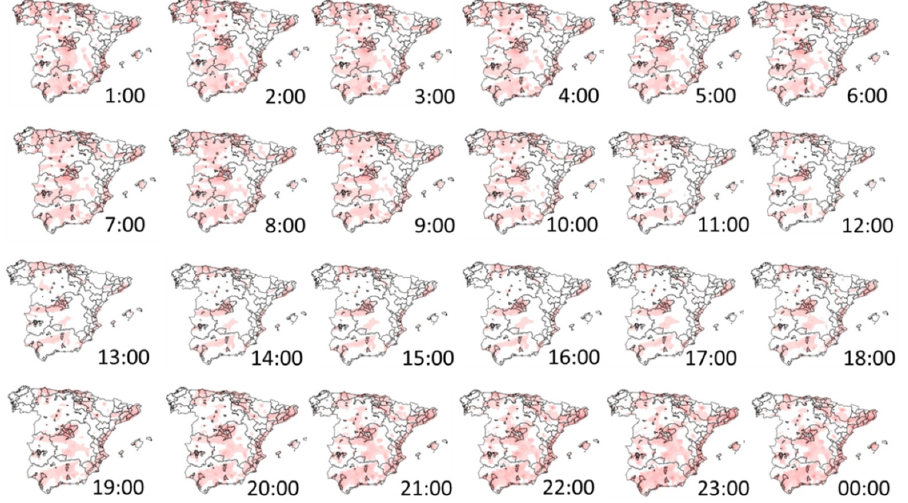
Figure 11. Hourly O 3 concentration difference maps ( µ g m − 3 ) between the WAM2030 scenario and 2016 for one day in winter (18 January 2016) ( µ g m − 3 ). Red colors indicate an increase in ozone for the WAM2030 scenario.